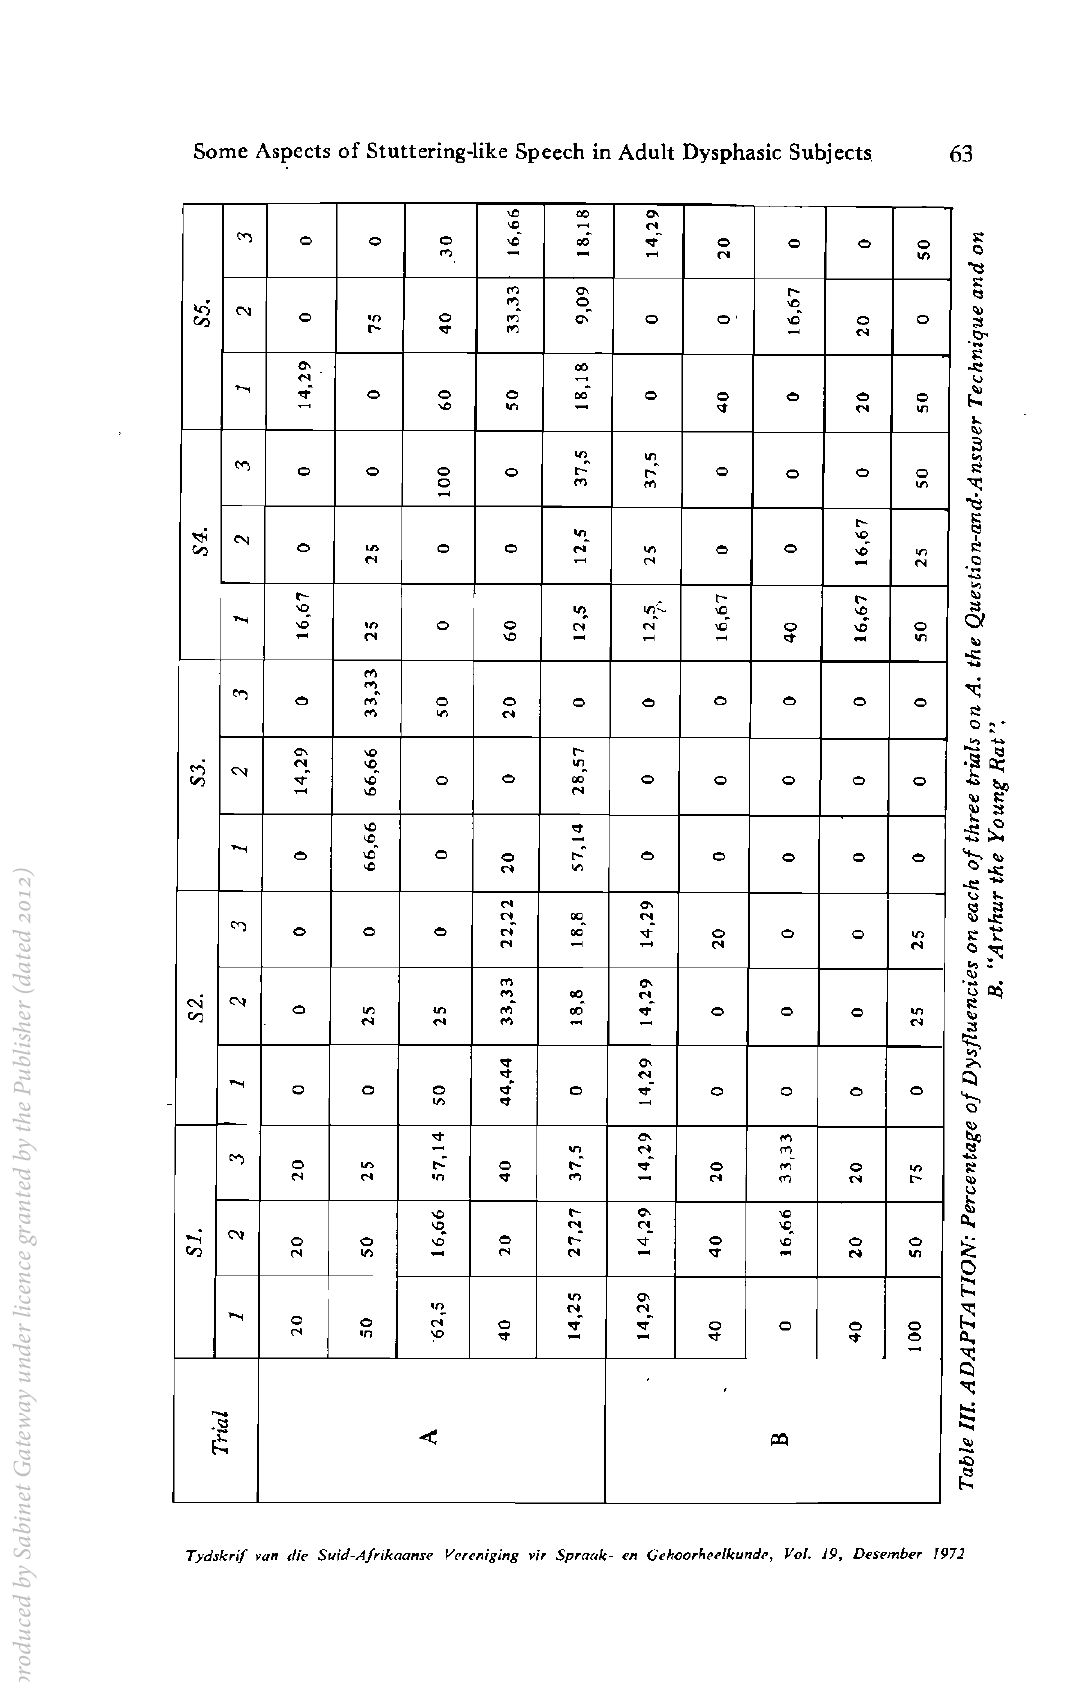
Tydskrif van die Suid-Afrikaanse Vereniging vir Spraak- en